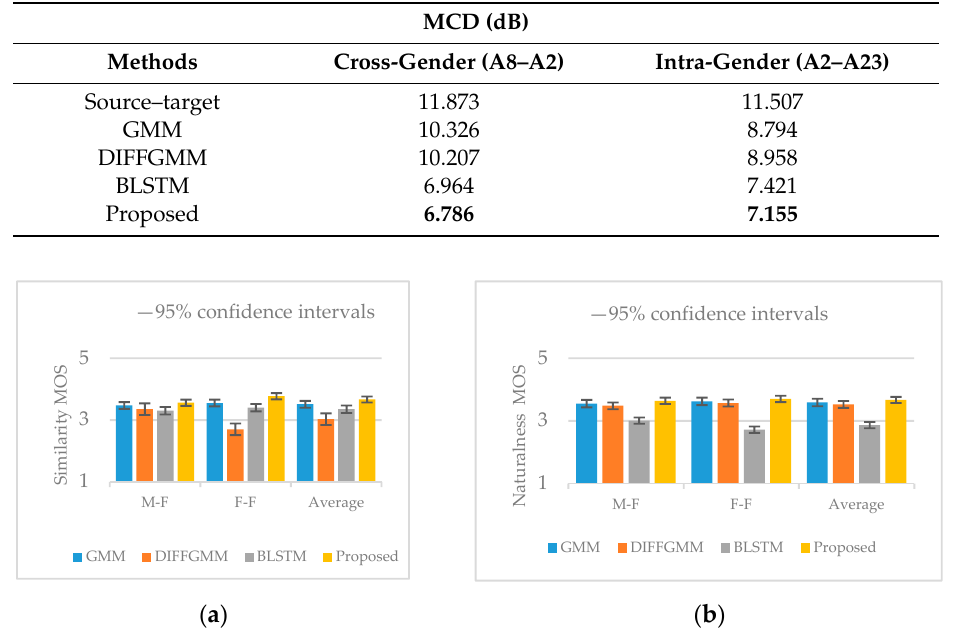
Figure 5. Results of subjective evaluation for different methods on THCHS-30 (15dB babble added to source): ( a ) MOS for similarity with 95% confidence intervals and ( b ) MOS for naturalness with 95% confidence intervals.